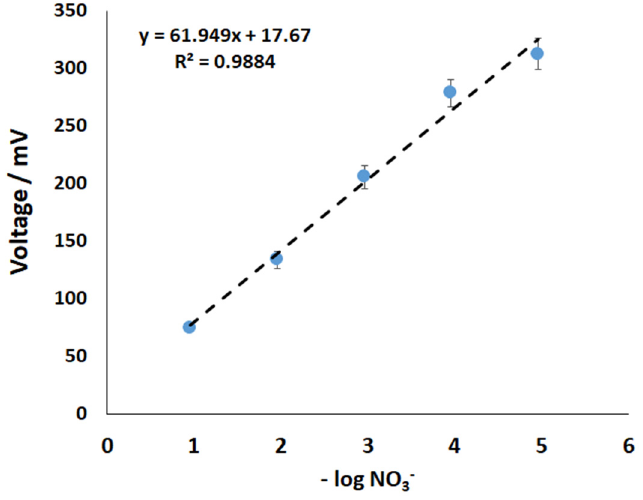
Figure 2. Nitrate sensor voltage response vs. nitrate (NaNO 3 ) solution concentration (calibration graph shown here is the negative log of molar concentrations). (See Table S1).